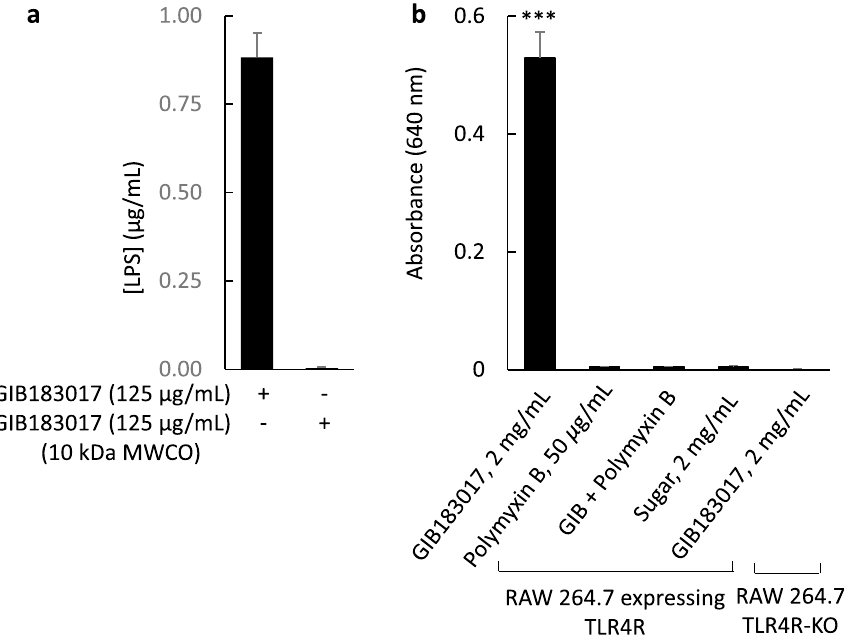
Figure 1. Endotoxin was detected in grey ironbark honey (183017, Table 1) using ToxinSensor™ endotoxin detection system ( a ). The endotoxin was removed by ultrafiltration using a 10 kDa molecular weight cut-off (MWCO) spin filter. The honey activated a toll-like receptor 4 (TLR4) – nuclear factor κB (NF-κB) signalling pathway in RAW 264.7 murine macrophages ( b ). Cells expressing secreted embryonic alkaline phosphatase (SEAP) formed a coloured product that was detected using colourimetry at 640 nm, after activation of TLR4. Activity was neutralised by incubation of the honey with 50 µg/mL polymyxin B for 1 h. No response to honey was detected in TLR4 knockout cells. Data are mean ± SEM; *** p < 0.001; ( a ) n = 3; ( b ) n = 3. Statistical analysis was performed using a one-way